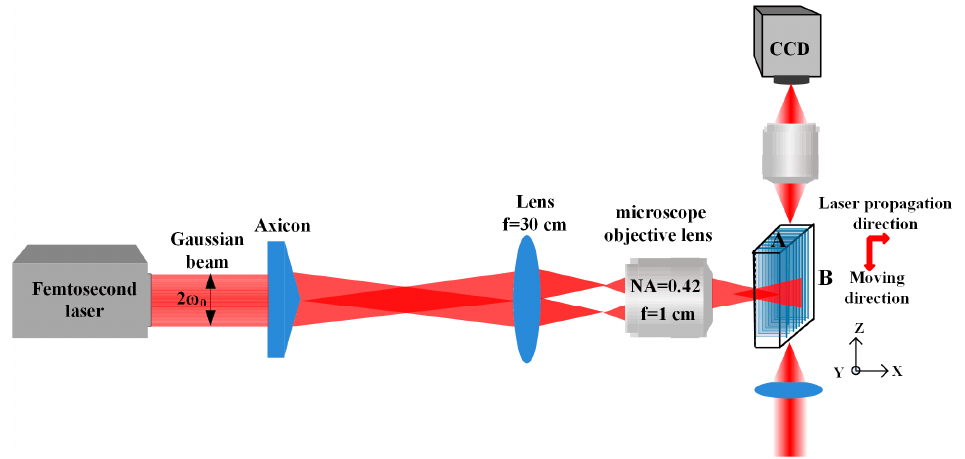
Figure 1. Schematic diagram of the experimental setup for writing parallel